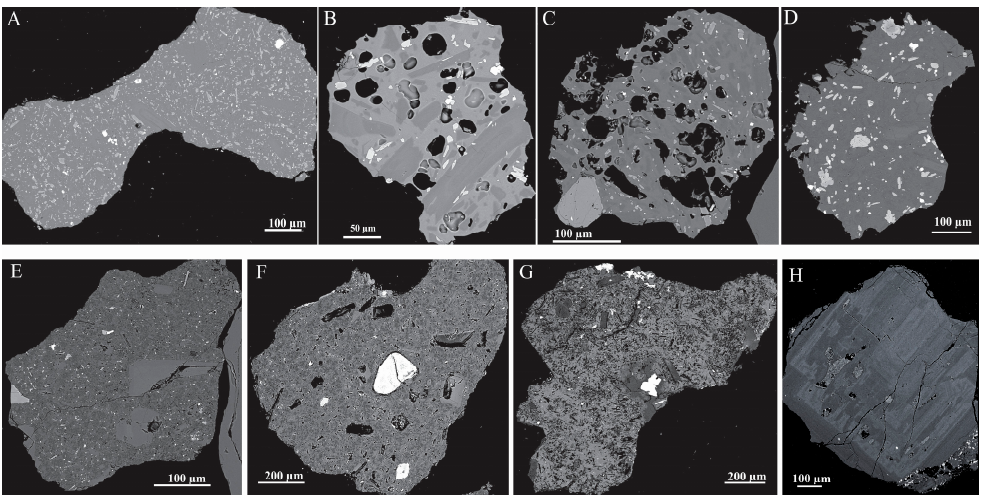
Figure 2. BSE image of volcanic ash: ( A ) BVR; ( B ) BVVR; ( C ) LBVR; ( D ) WVVR; ( E ) SR; ( F ) OR; ( G ) AVR; and ( H ) IP